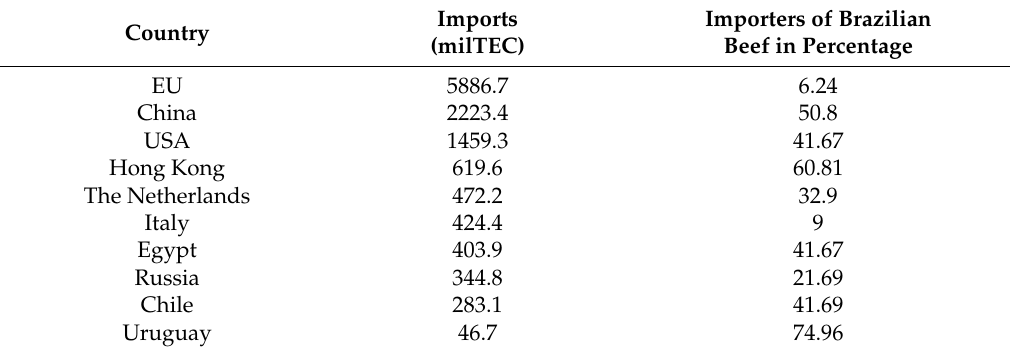
Table 2. Largest Beef Importers and Consumers.